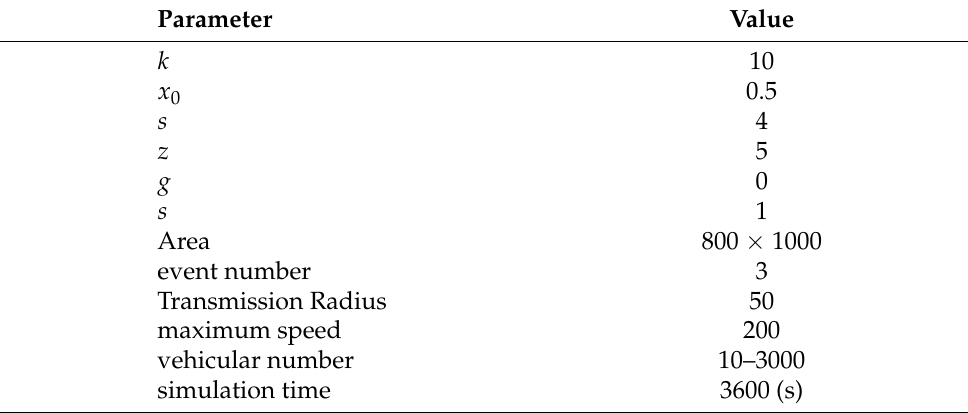
Table 2. Table of